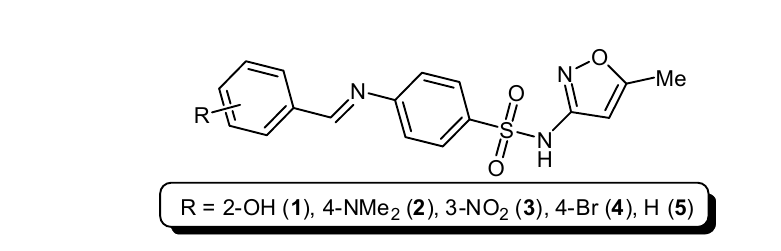
Figure 1. Structure of compounds 1 – 5 .